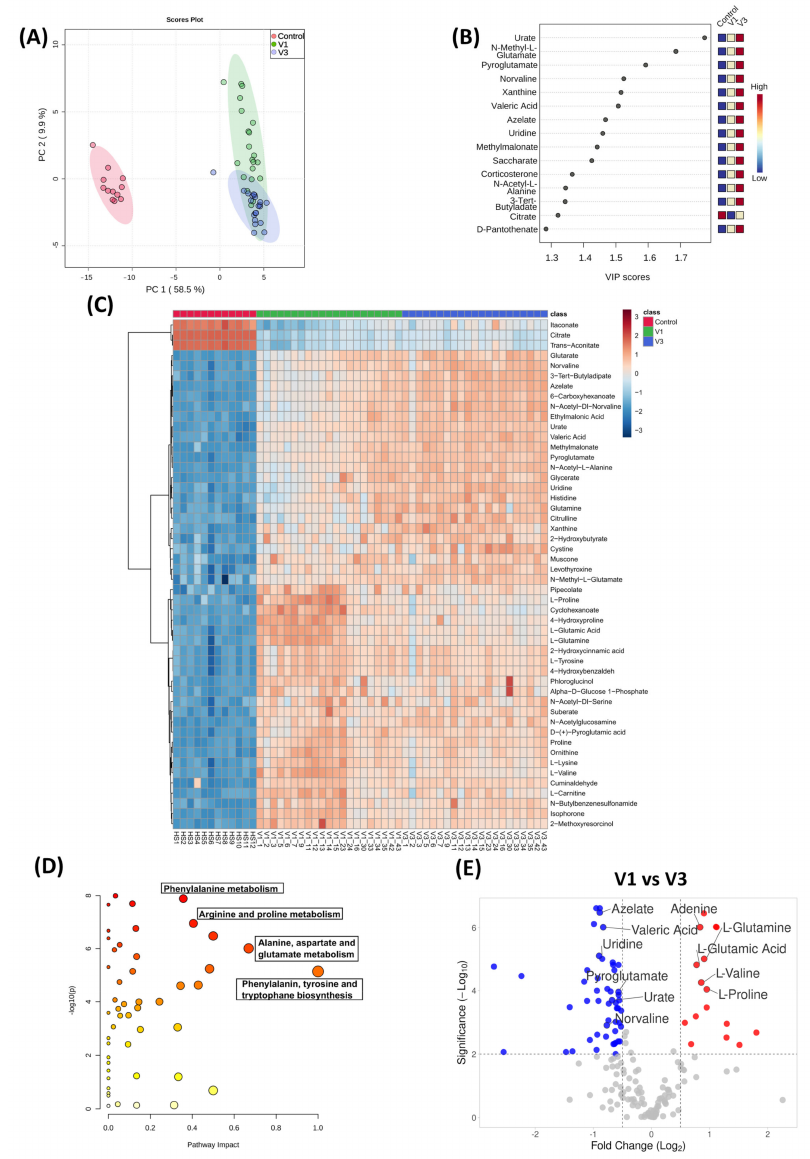
Figure 5. Metabolomic analysis of SARS-CoV-2 patient plasma samples, compared to age- matched healthy controls. ( A ) Principal component analysis of the untargeted metabolites of the three groups. ( B ) Important features identified by PLS-DA. The colored boxes indicate relative concentrations of designated metabolites in each study group. ( C ) Hierarchical cluster analysis is shown as a heatmap of the top 50 metabolites (FDR < 0.05). ( D ) Pathway enrichment analysis using KEGG of all the metabolites (n = 158) significantly altered during COVID-19 infection. ( E ) Volcano plot comparing the significantly changed ( p = 0.001, FC > 1.5) metabolites during the early (V1) and later stages of disease